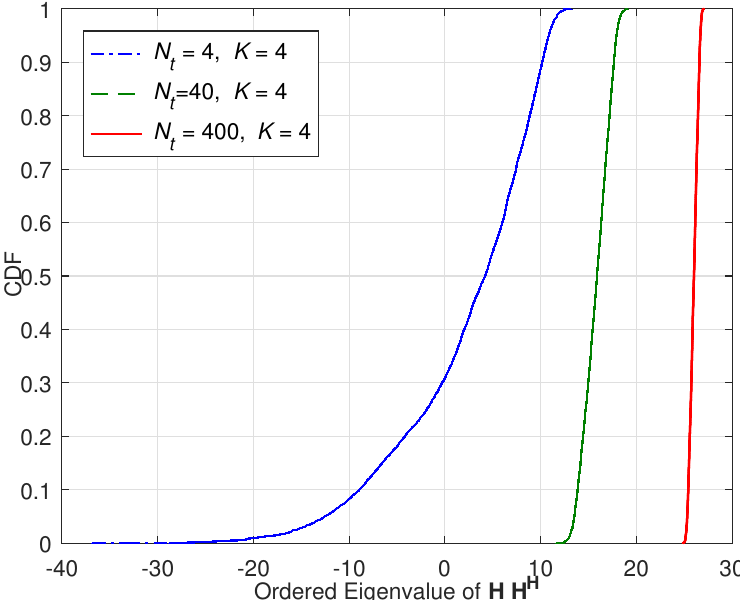
Figure 1. Example of channel hardening effect, when N t = 4, 40, 400 and K = 4, CDF: cumulative distribution